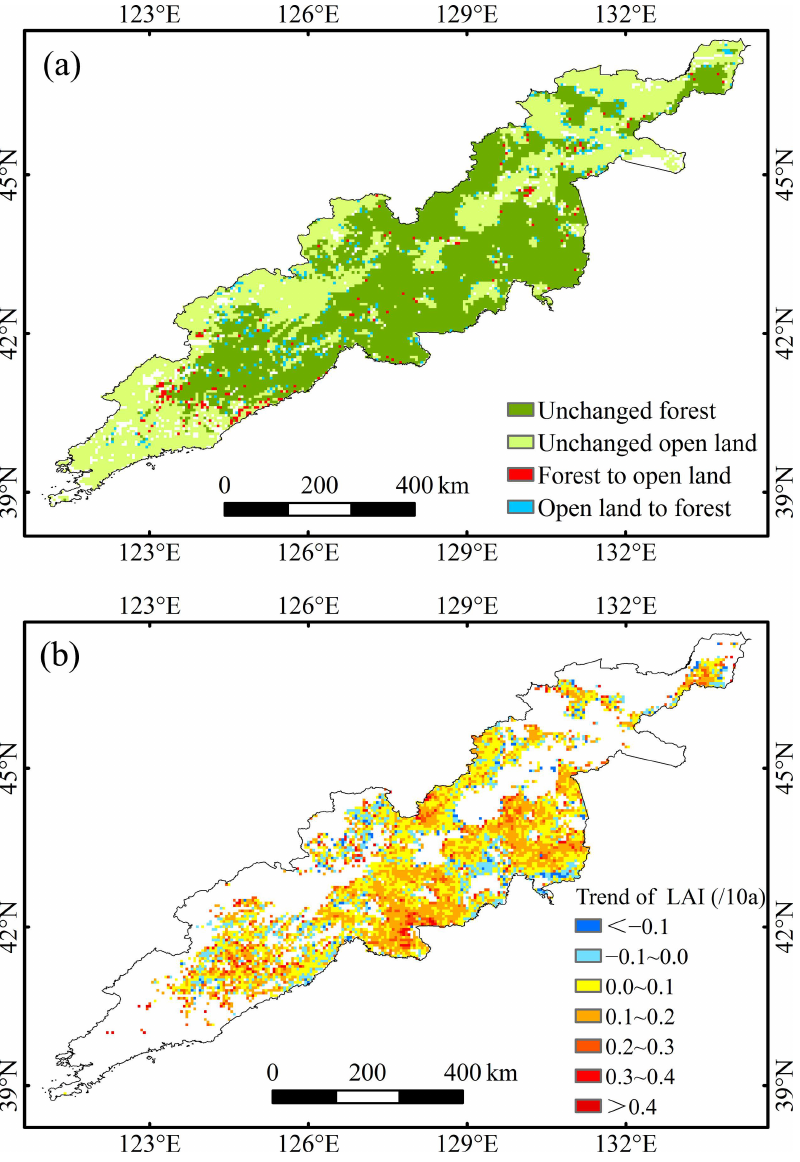
Figure 2. Changes of distribution ( a ) and vegetation coverage ( b ) of forests in Changbai Mountain from 2003 to